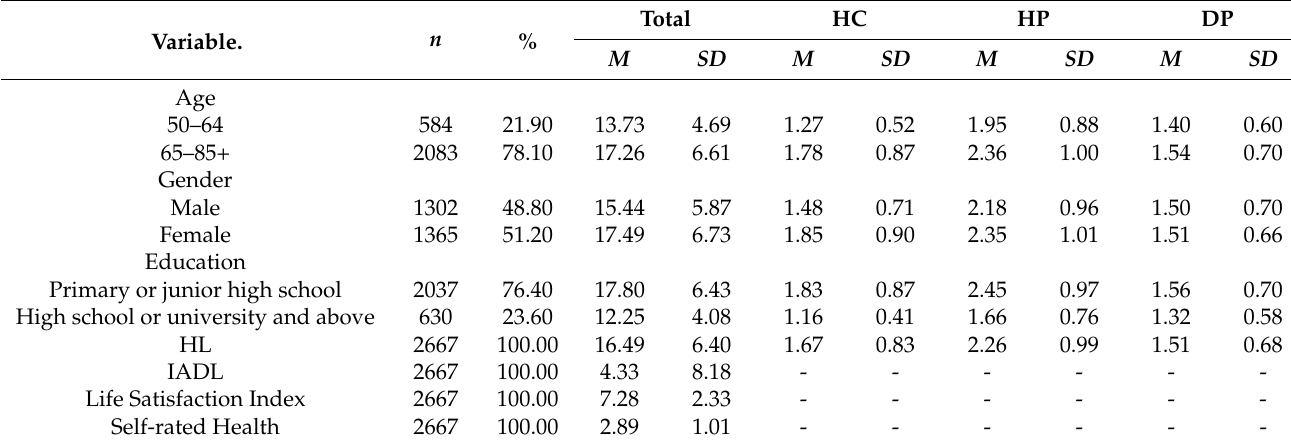
Table 1. Socio-demographic status and TLSA health literacy scores of the participants.